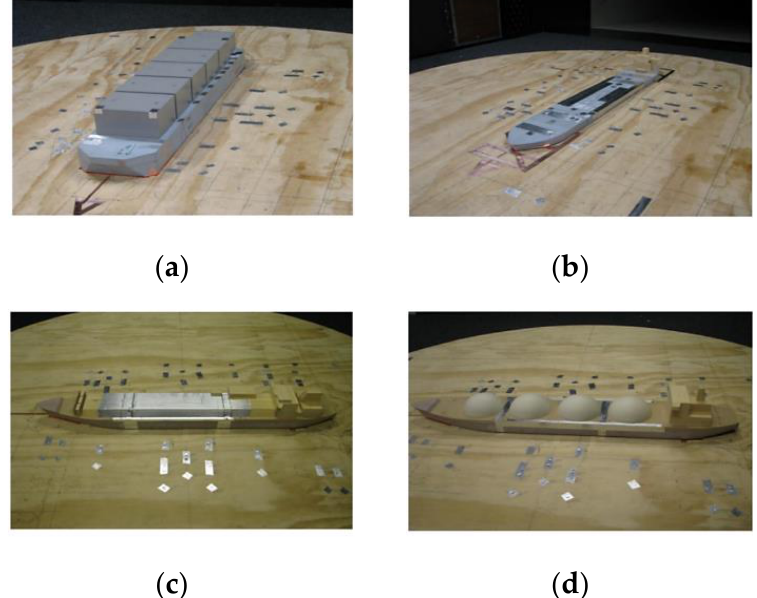
Figure 2. Vessel models for wind tunnel tests. ( a ) FPSO; ( b ) shuttle tanker; ( c ) membrane-type LNGC; and ( d ) moss-type LNGC.